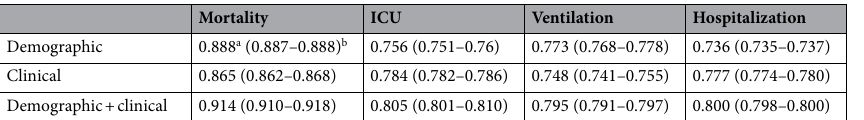
Table 1. The classification performance of the final models. a Mean b 95% Confidence Interval.